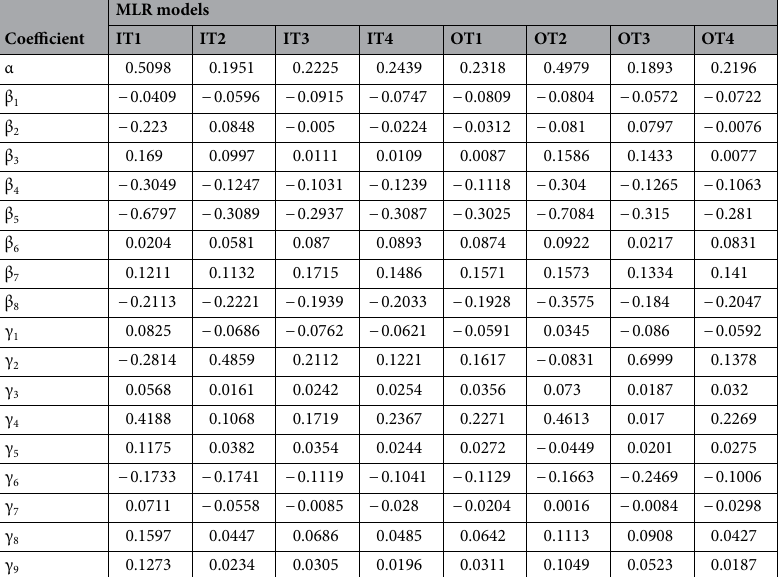
Table 8. Constants and variable coefficients of MLR